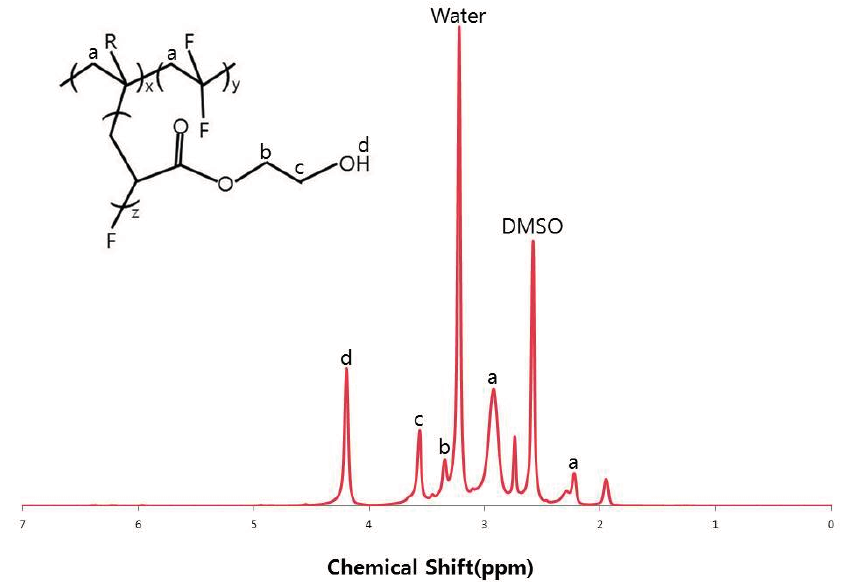
Figure 3. 1H-NMR spectra of PVDF-g-PHEA copolymer.